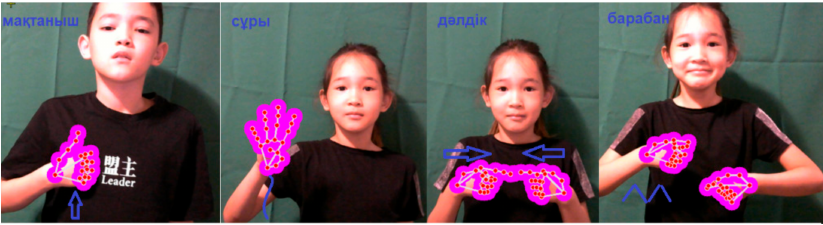
Figure 5. Example of dynamic gestures.